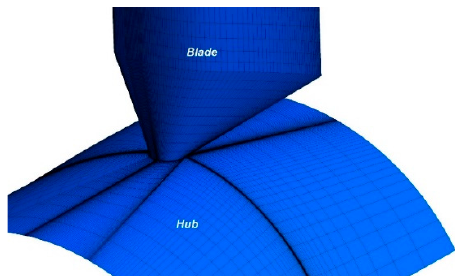
Figure 3. Zoom view on the mesh details.